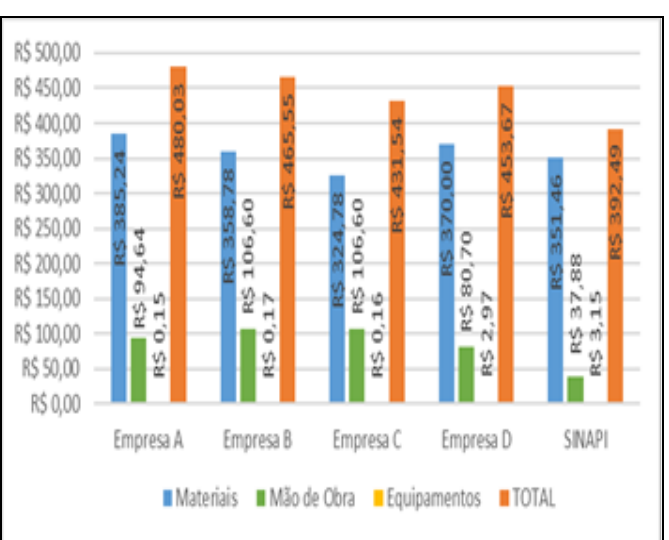
Figura 4 - Análise contábil entre os custos das empresas e do SINAPI